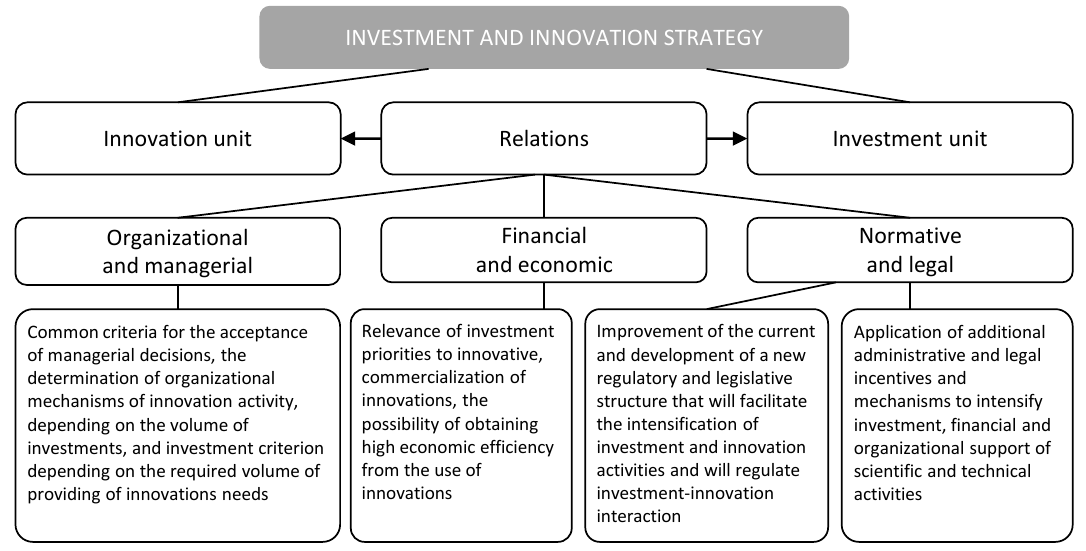
Figure 2. Strategy of investment and innovation